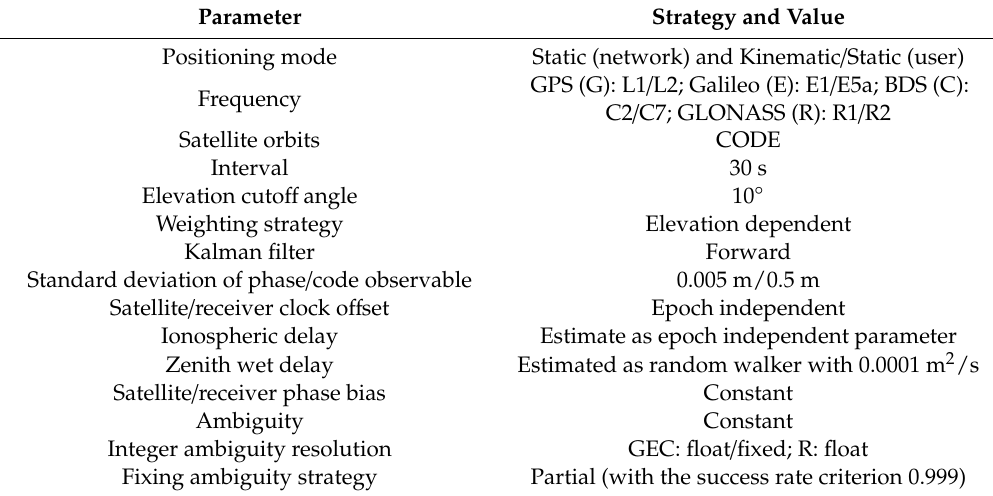
Table 1. Summary of the strategy of data processing. GPS, Global Positioning System; Galileo, European Global Navigation Satellite System; BDS, BeiDou Navigation Satellite System; GLONASS,